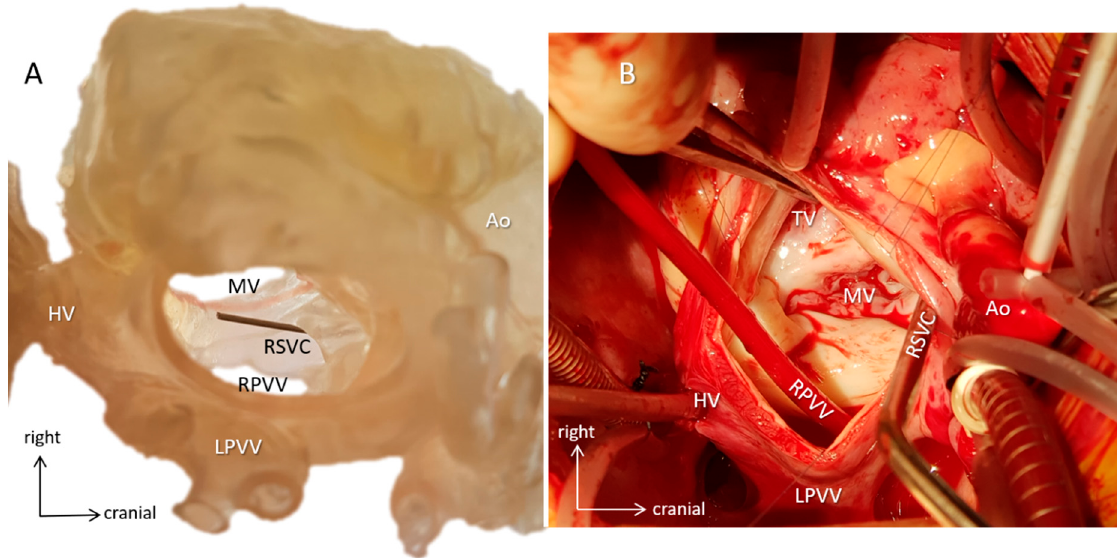
Figure 8. Surgical simulation. Case 13 with dextrocardia (mirror-image arrangement, bilateral SVCs, hemiazygos continuity of interrupted IVC, common atrium, incomplete AV defect, valvar pulmonary stenosis, vascular ring). ( A ) A 3D-printed hollow model viewed from the orientation of the surgeon standing on the left side of the patient demonstrates the intracardiac anatomy. A probe emerges in the mouth of the right superior vena cava (RSVC). By identifying anatomical landmarks, e.g., the AV valves and the entrances of the pulmonary and hepatic veins, surgical steps can be simulated, and size and shape of the baffle can be designed preoperatively. ( B ) Intraoperative representation of the same anatomy. The surgeon identifies structures already familiar with from the 3D model (e.g., metal suction tube is in the right superior vena cava), and the course of the operation progresses along with the preoperative plans. The 3D model and the intraoperative image are closely matched. Abbreviations: Ao: aorta, HV: hepatic veins, LPVV: left-sided pulmonary veins, MV: mitral valve, RPVV: right-sided pulmonary veins, RSVC: right superior vena cava, TV: tricuspid valve.